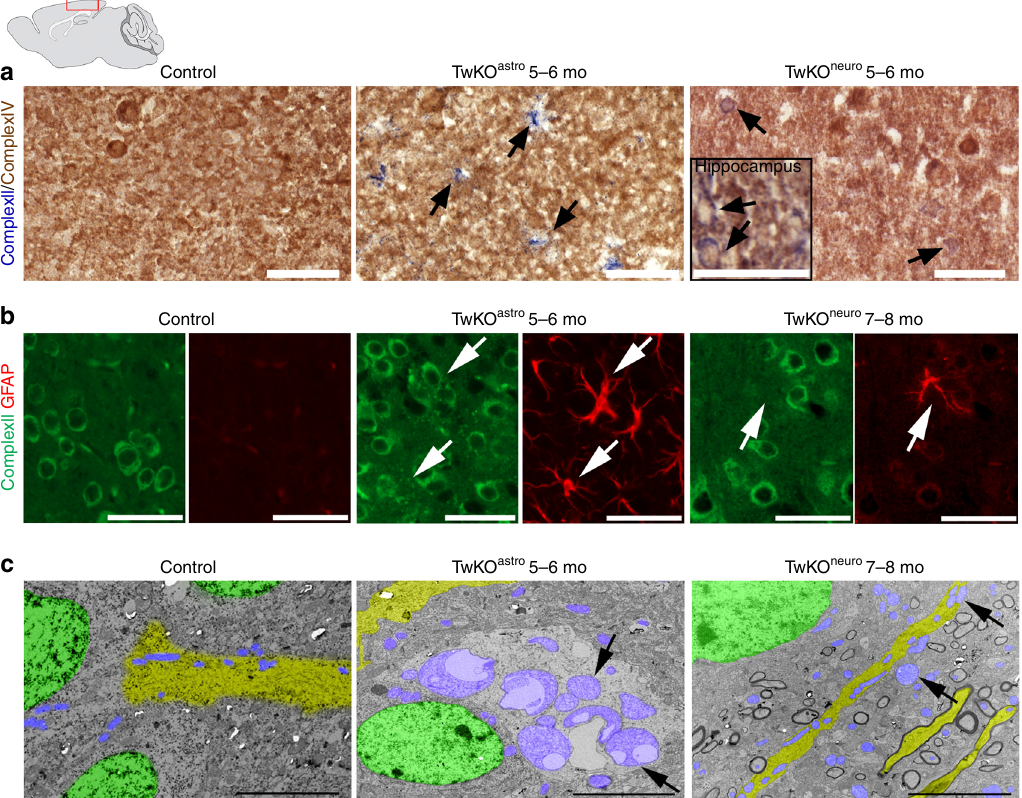
Fig. 4 OXPHOS activity and mitochondrial structure in Twinkle KOs. a In situ histochemical activity analysis of mitochondrial respiratory chain enzymes in cortex. Brown: Complex IV, contains mtDNA-encoded subunits. Blue: fully nuclear-encoded Complex II. Arrows: respiratory chain de fi cient cells with astrocyte (TwKO astro ) or neuronal (TwKO neuro ) morphology. Inset in TwKO neuro : hippocampus, COX-de fi cient cells pointed with arrows. b Mitochondrial Complex II (SDHA, green) immuno-co-stained with astrocytes (GFAP, red), arrows point the same cells. TwKO astro astrocytes show punctate mitochondrial accumulations. c Ultrastructure of mitochondria (arrows and purple pseudocolor). Green = nuclei, yellow = neuronal projections. Brain graph shows sampling site. Scale bars: 50 μ m ( a , b ), 5 μ m ( c